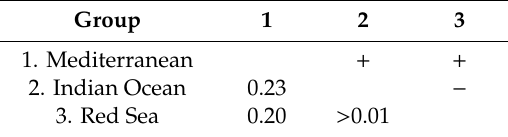
Table 4. Pairwise F ST values between regional groups. Above the diagonal with a + are indicated the statistically well-supported estimations ( p value <